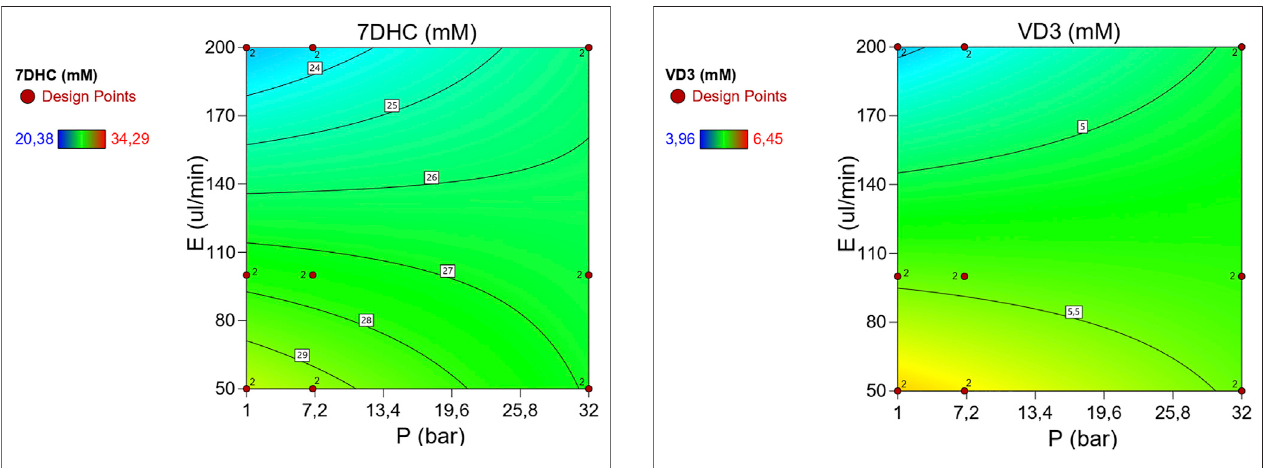
decompression speed since the interaction was not